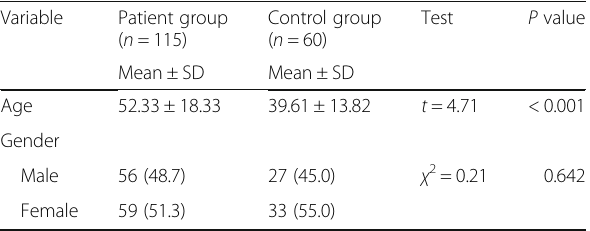
Table 1 The age and gender distribution of the patients and control subjects included in the study Variable